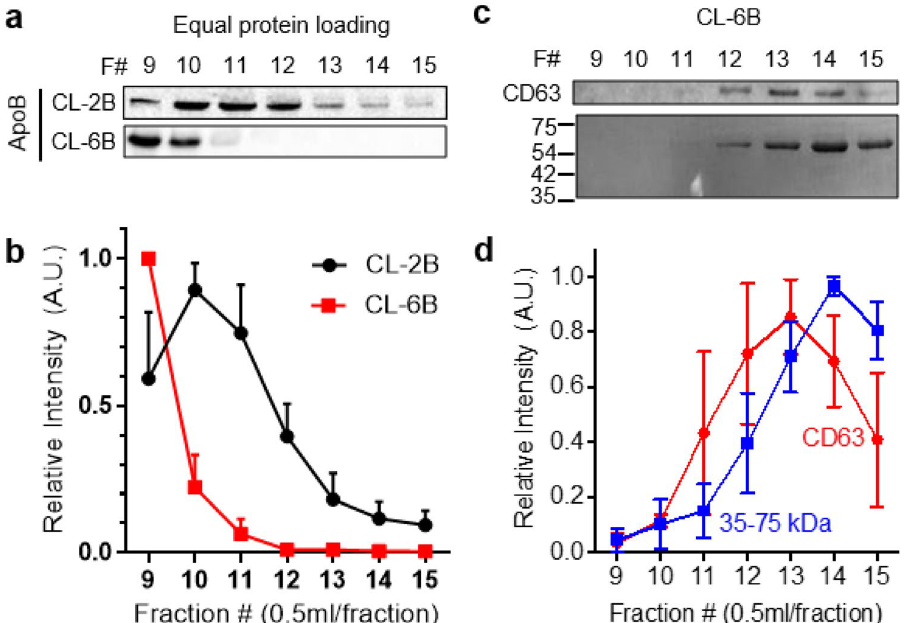
Figure 3. Isolation of aggregated LDLs by CL-6B columns. ( a ) Western blot (equal protein loading) analysis of ApoB on eluate fractions of BM plasma either separated by CL-2B or CL-6B columns. ( b ) Relative intensities of ApoB bands obtained in ( a ) (n = 3). ( c ) Western blot (equal protein loading) analysis of CD63 and soluble proteins (MW: 35–75 kDa) on eluate fractions of BM plasma separated using the CL-6B column. ( d ) Relative intensities of ApoB and soluble protein bands in ( c ) (n =